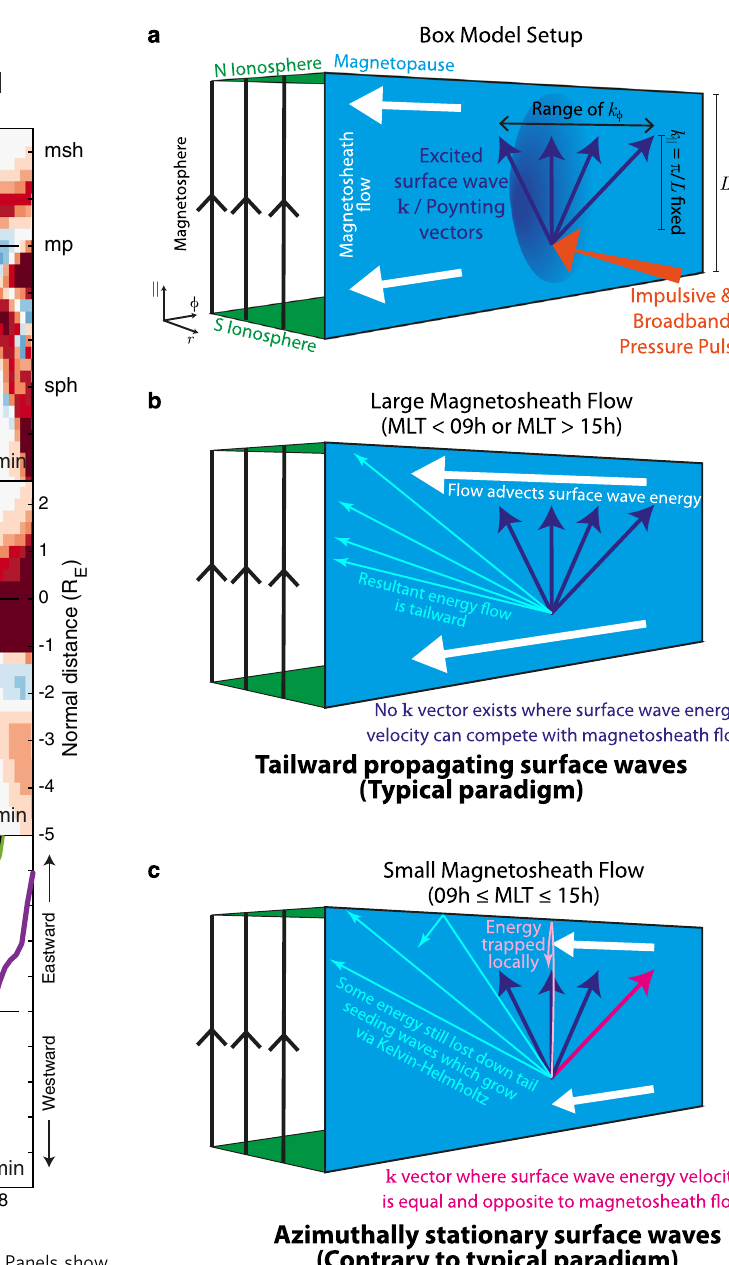
Fig. 9 Cartoon illustrating the results of this study. a shows the box model magnetosphere, magnetosheath fl ow (white), and surface mode wavevectors (dark blue) excited by the pressure pulse (orange). Subsequent panels depict the resultant energy fl ow (lighter coloured arrows) of the surface mode wavevectors for ( b ) large and ( c ) small magnetosheath fl